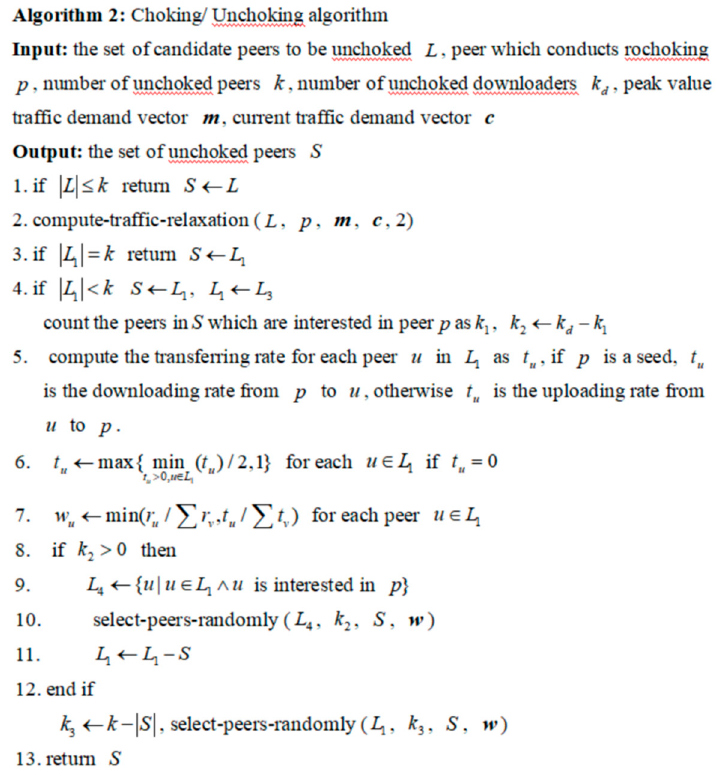
Figure 3. Pseudo code of the choking/unchoking algorithm.